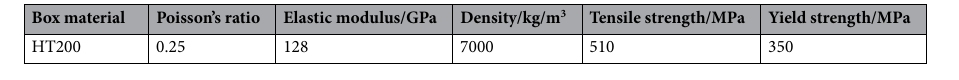
Table 4. Material